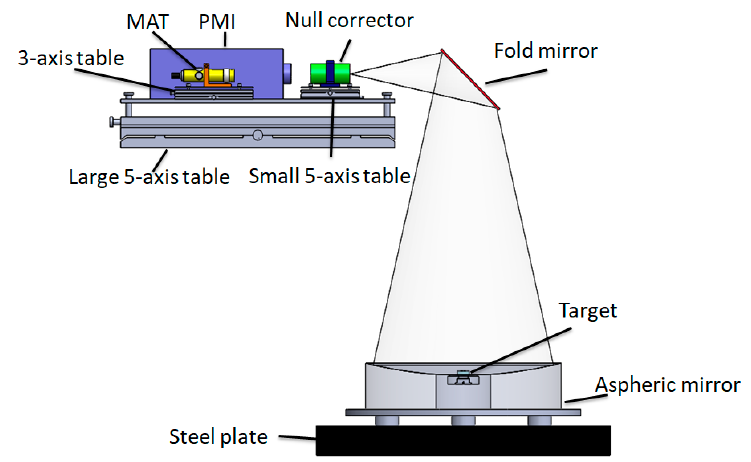
Figure 3. Setup to measure vertex position of aspheric mirror. Figure 3. setup to measure vertex position of aspheric mirror.